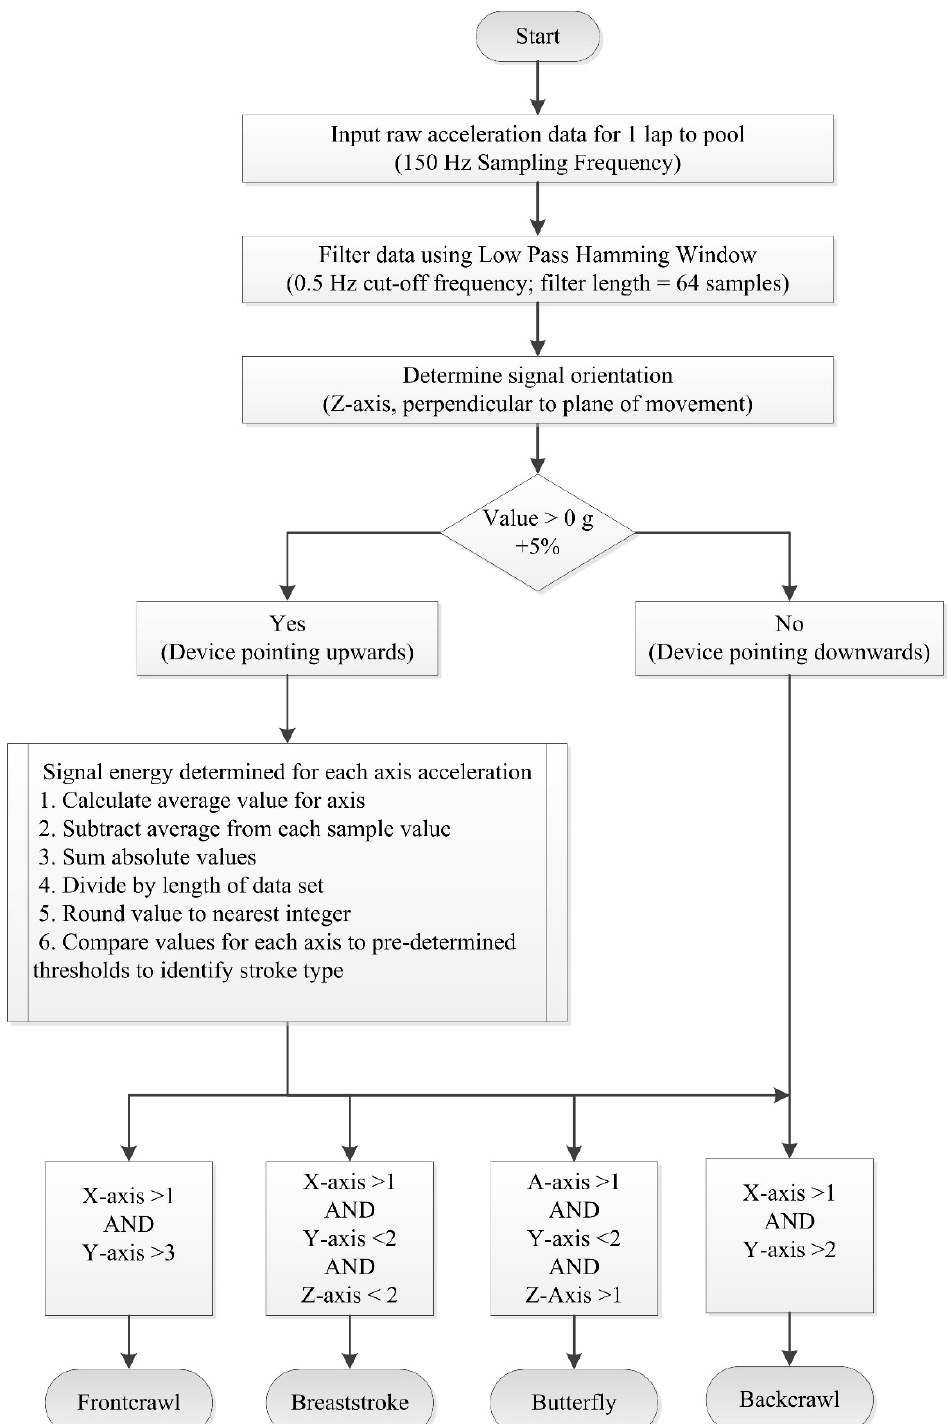
Figure 10. Flowchart for a stroke identification algorithm used to distinguish between each of the four competitive swimming strokes. Adapted from Davey, Anderson and James [11].